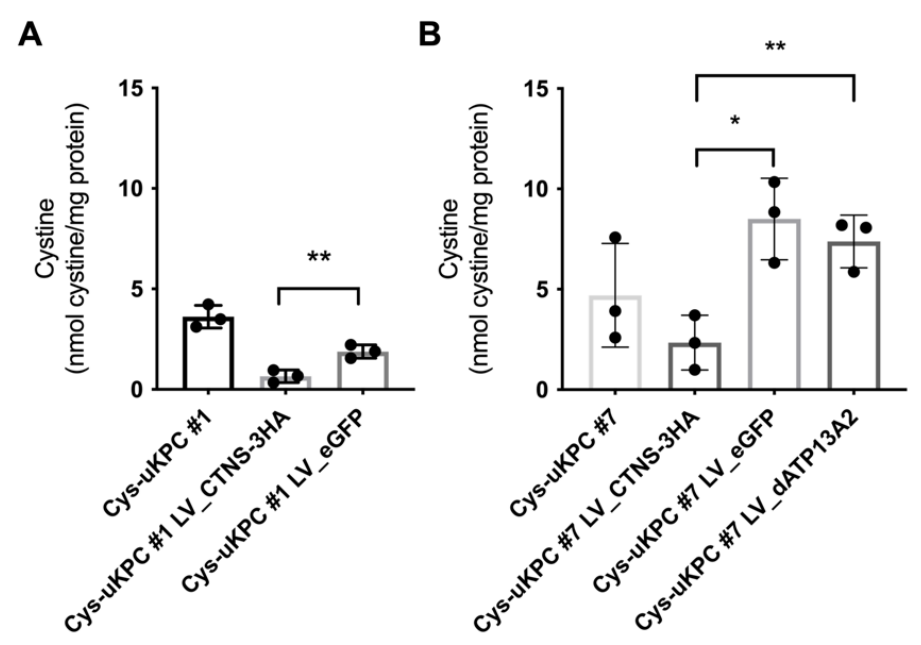
compared to their vehicle controls (Figure 5; panel A: Cys-uKPC #1; panel B: Cys-uKPC #2).